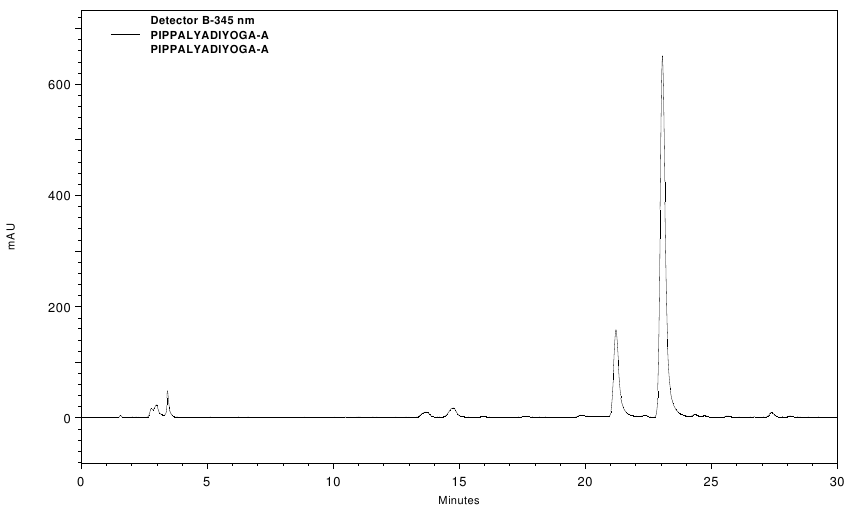
Table 3 . Determination of standard deviation and coefficient of variation for standard